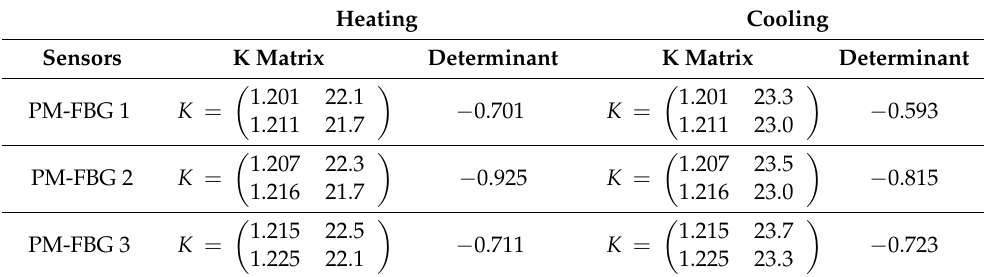
Table 2. Determinant values calculated from the matrixial method during heating and cooling steps. Heating Cooling Sensors K